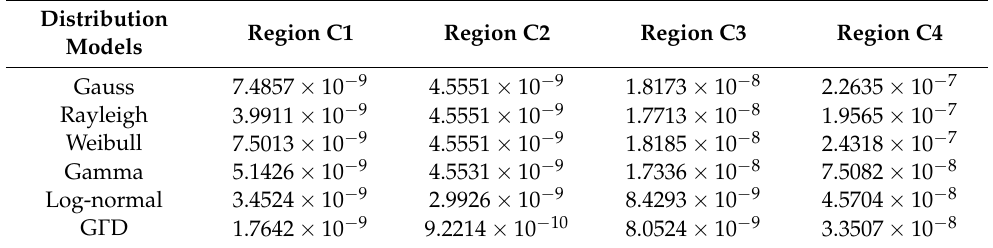
Table 1. The fitting MSD values of different statistical models for clutter tail in different